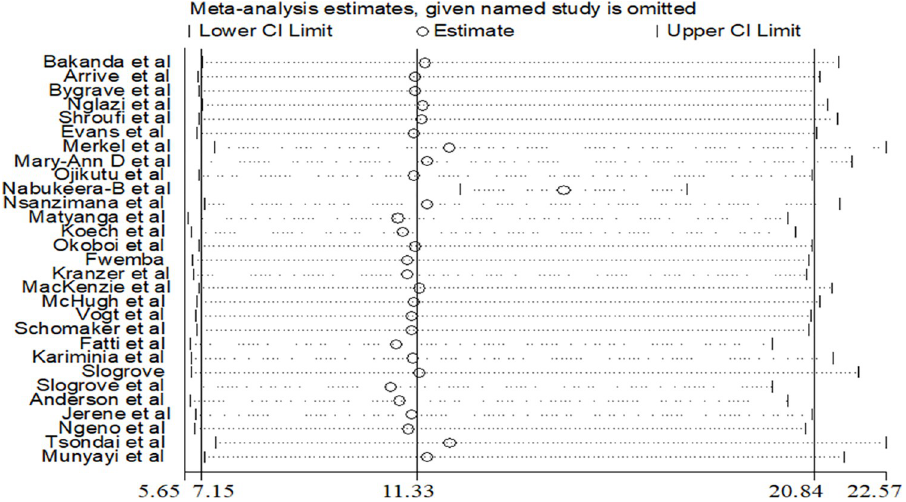
Fig 3. Sensitivity analysis of the pooled prevalence